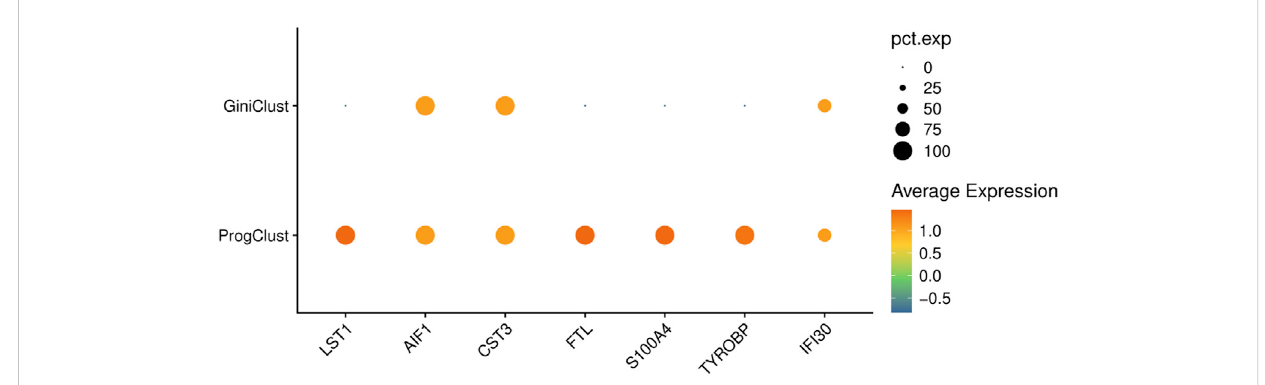
FIGURE 1 The bubble plots of CD14 + Monocyte cell ’ s marker genes selected by different methods on a sampled data from PBMC68K dataset. ProgClust fi nd 7 gene markers while GiniClust can only fi nd three gene